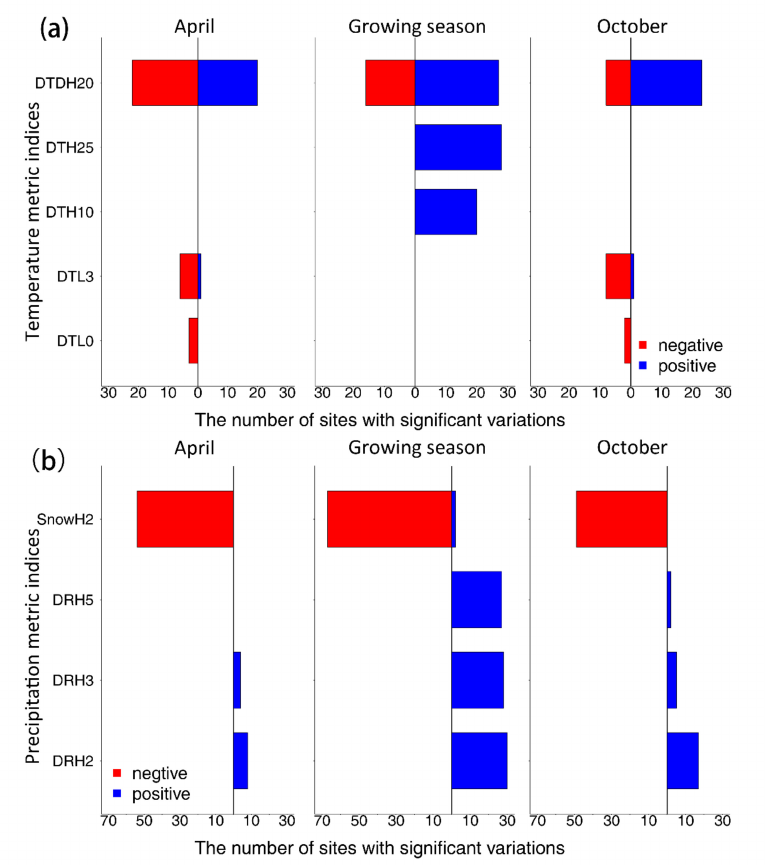
Figure 3. The number of stations with significant annual variability in the temperature ( a ) and precipitation ( b ) metric indices with ecological